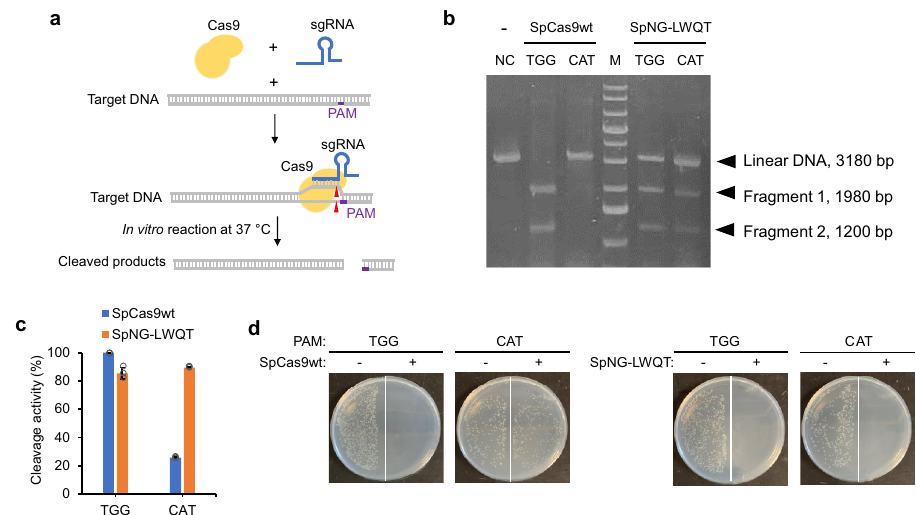
Fig. 3 Restoring the nuclease activity SpdNG-LWQT toward 5 ′ -TGG-3 ′ and 5 ′ -CAT-3 ′ PAMs. a In vitro DNA cleavage assay for Cas9 activity. Puri fi ed his 6 -tagged Cas9 proteins were incubated with in vitro transcribed sgRNA and linearized DNA targets, and the reaction was performed at 37 °C. b DNA cleavage by SpCas9wt and SpNG-LWQT with sgegfp targeting 5 ′ -TGG-3 ′ or 5 ′ -CAT-3 ′ PAM. DNA target with SpCas9wt but without any sgRNA was served as the negative control. Representative image from two independent repeats. c In vivo plasmid DNA cleavage assay with SpdCas9wt (blue) and SpNG-LWQT (orange). Plasmid pCS- Plpp1 -SpCas9wt or pCS- Plpp1 -SpNG-LWQT was transferred into E. coli BW25113(F ′ ) harboring pZE-eGFP-sgegfp containing sgegfp targeting 5 ′ -TGG-3 ′ or 5 ′ -CAT-3 ′ PAM targets on eGFP. Data indicated the mean ± standard deviation ( n = 3 independent biological replicates). d In vivo chromosomal DNA cleavage assay. Plasmid pCS- Plpp1 -SpCas9wt or pCS- Plpp1 -SpNG-LWQT was transferred into E. coli BW25113(F ′ )::eGFP harboring pZE-sgegfp containing sgegfp targeting 5 ′ -TGG-3 ′ or 5 ′ -CAT-3 ′ PAM targets on chromosomally integrated eGFP. Cells were plated on Luria-Bertani (LB) plates containing 0.5 mM IPTG and appropriate antibiotics. Negative controls ( − ) were transformed with empty pCS27 plasmid. Representative image from two independent repeats. Source data are provided as a Source Data fi le.